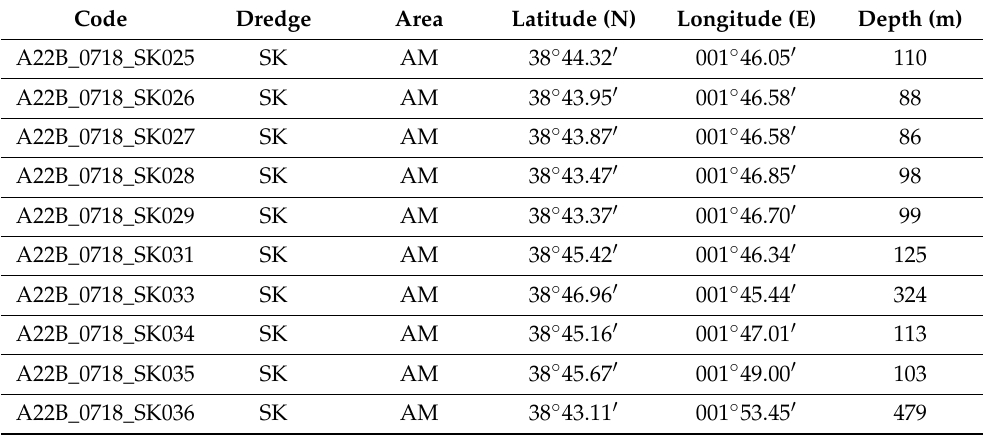
Table A1. Characteristics of the sampling stations carried out with Shipek (SK) and Box–Corer (BC) dredges in the Mallorca Channel seamounts Ses Olives (SO), Ausias March (AM), and Emile Baudot (EB) as well as those of the central basin (CB) and the main pockmark fields (PK) during the INTEMARES